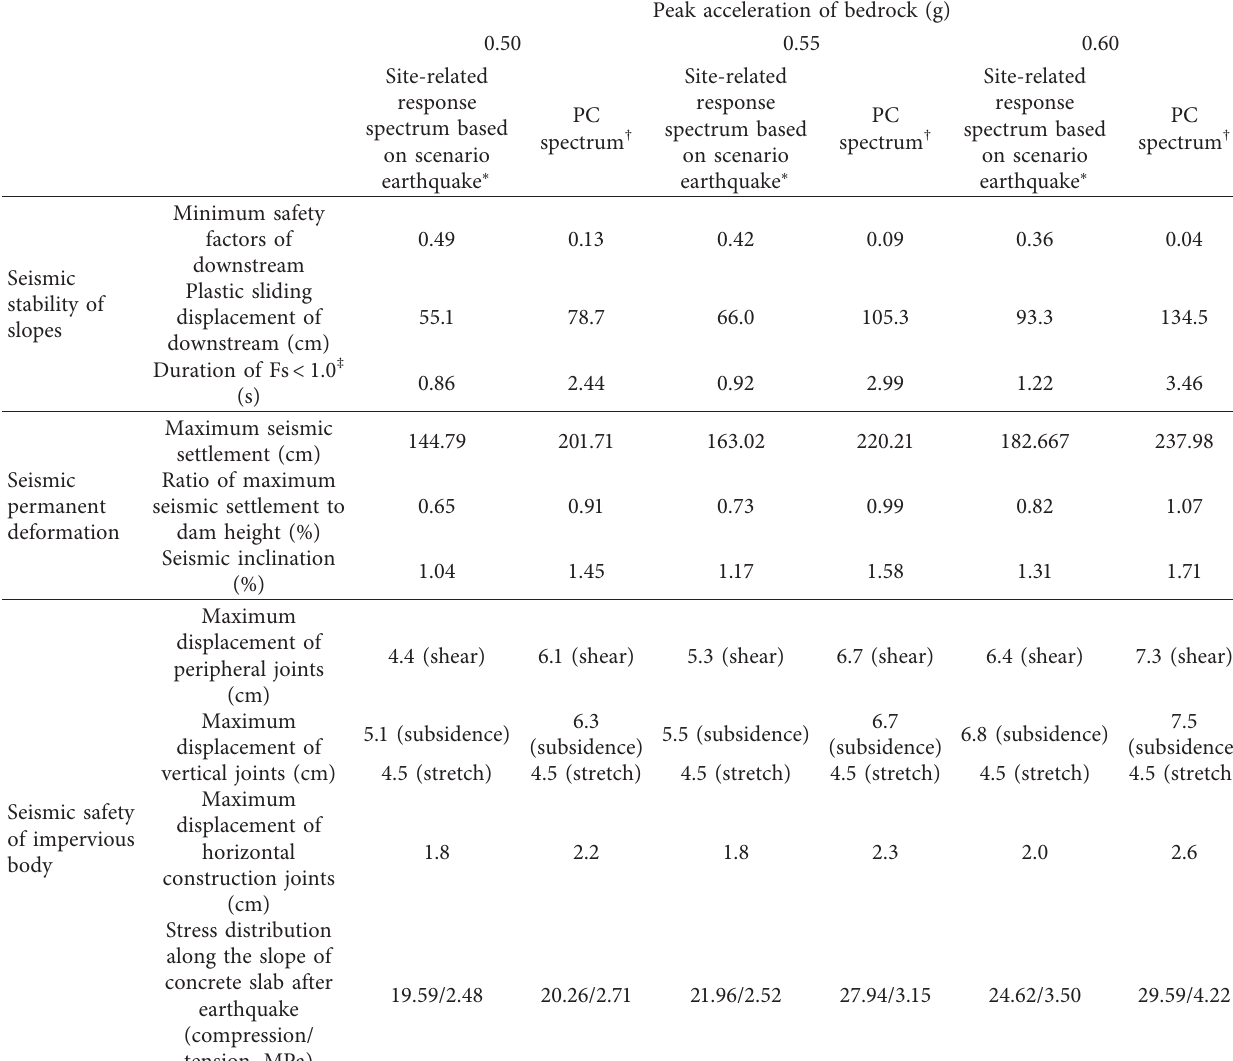
Table 6: Ultimate seismic capability of the high concrete-faced rockfill